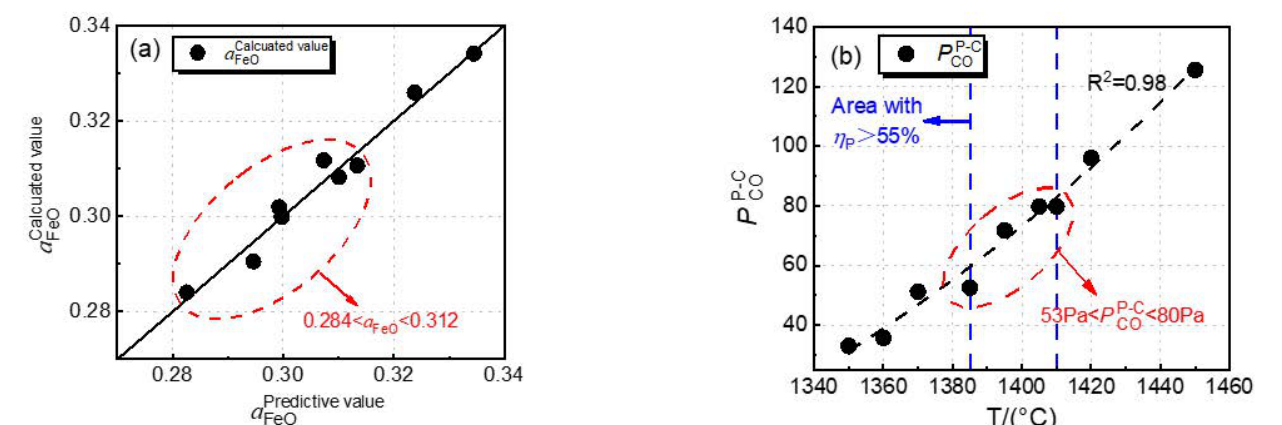
of selective oxidation reaction of CO